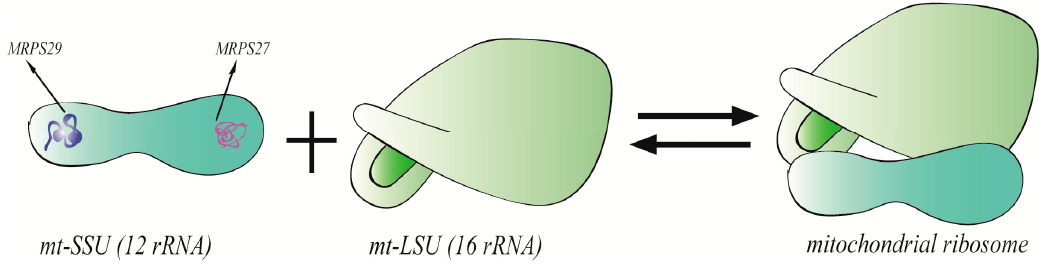
Figure 1. Mitochondrial ribosomes are composed of mt-SSU and mt-LSU. The overall structure of mt-SSU is divided into three areas: head, platform, and foot. The head region is characterized by the presence of MRPS29 and the foot region is characterized by MRPS27.